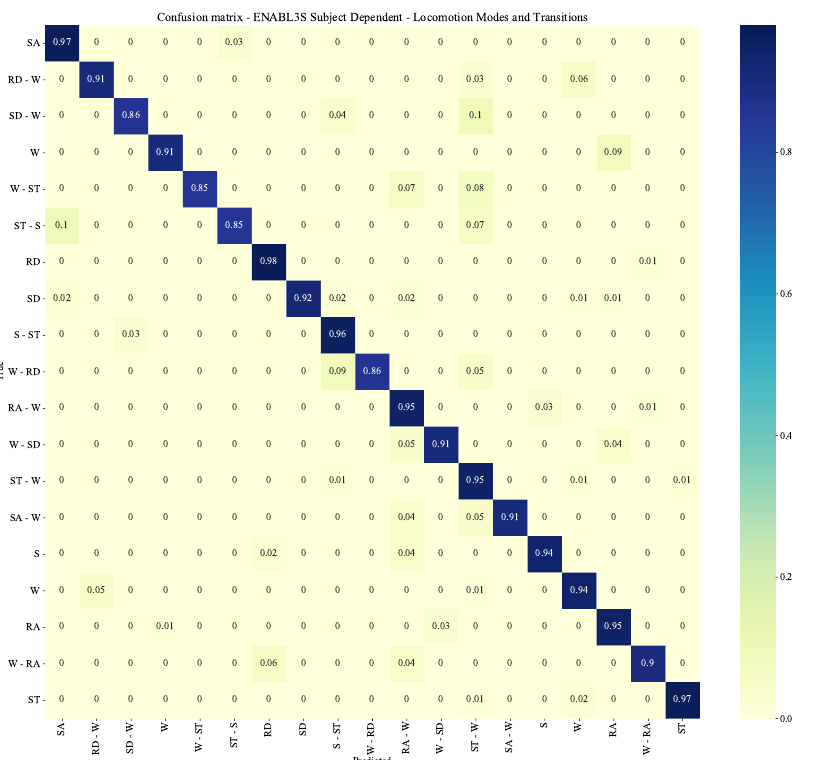
Figure 10. Confusion matrix for the ENABL3S subject dependent scenario with an CNN-LSTM for the locomotion modes and transitions’ classification.